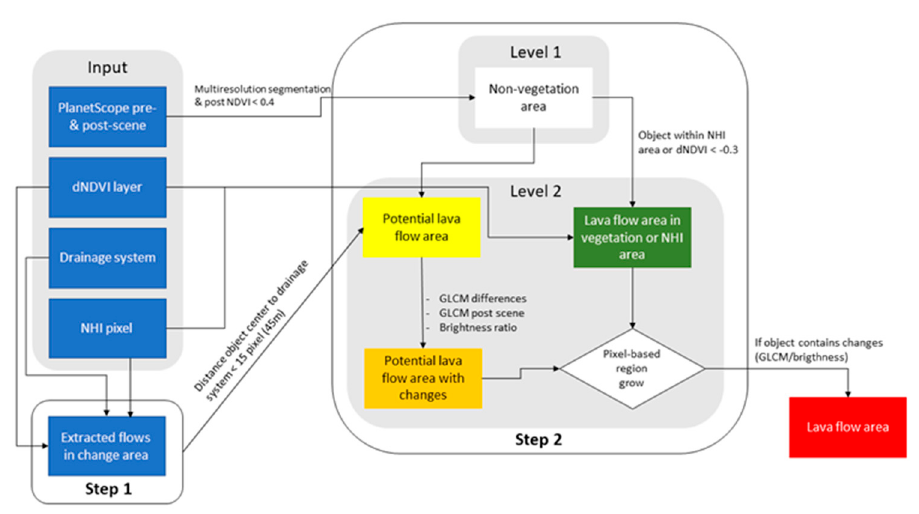
Figure 2. Workflow of OBIA change detection based on NHI pixels and the dNDVI area. Input data: pre- and post-PlanetScope scene, temporally aggregated NHI pixels, dNDVI layer, and the drainage system. Step 1: extraction of the drainages in the overprint area (NHI or dNDVI area); step 2: classification of segments in the unvegetated areas using the combination of distance to drainage and changes in texture (GLCM) and brightness. Starting from the “lava flow area in vegetation or NHI area” objects, a pixel-based region growing into the “potential lava flow area with change” change areas is used to model the lava flow to its point of origin.